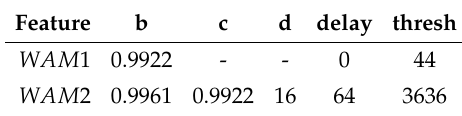
Table 6. Parameters of WAM